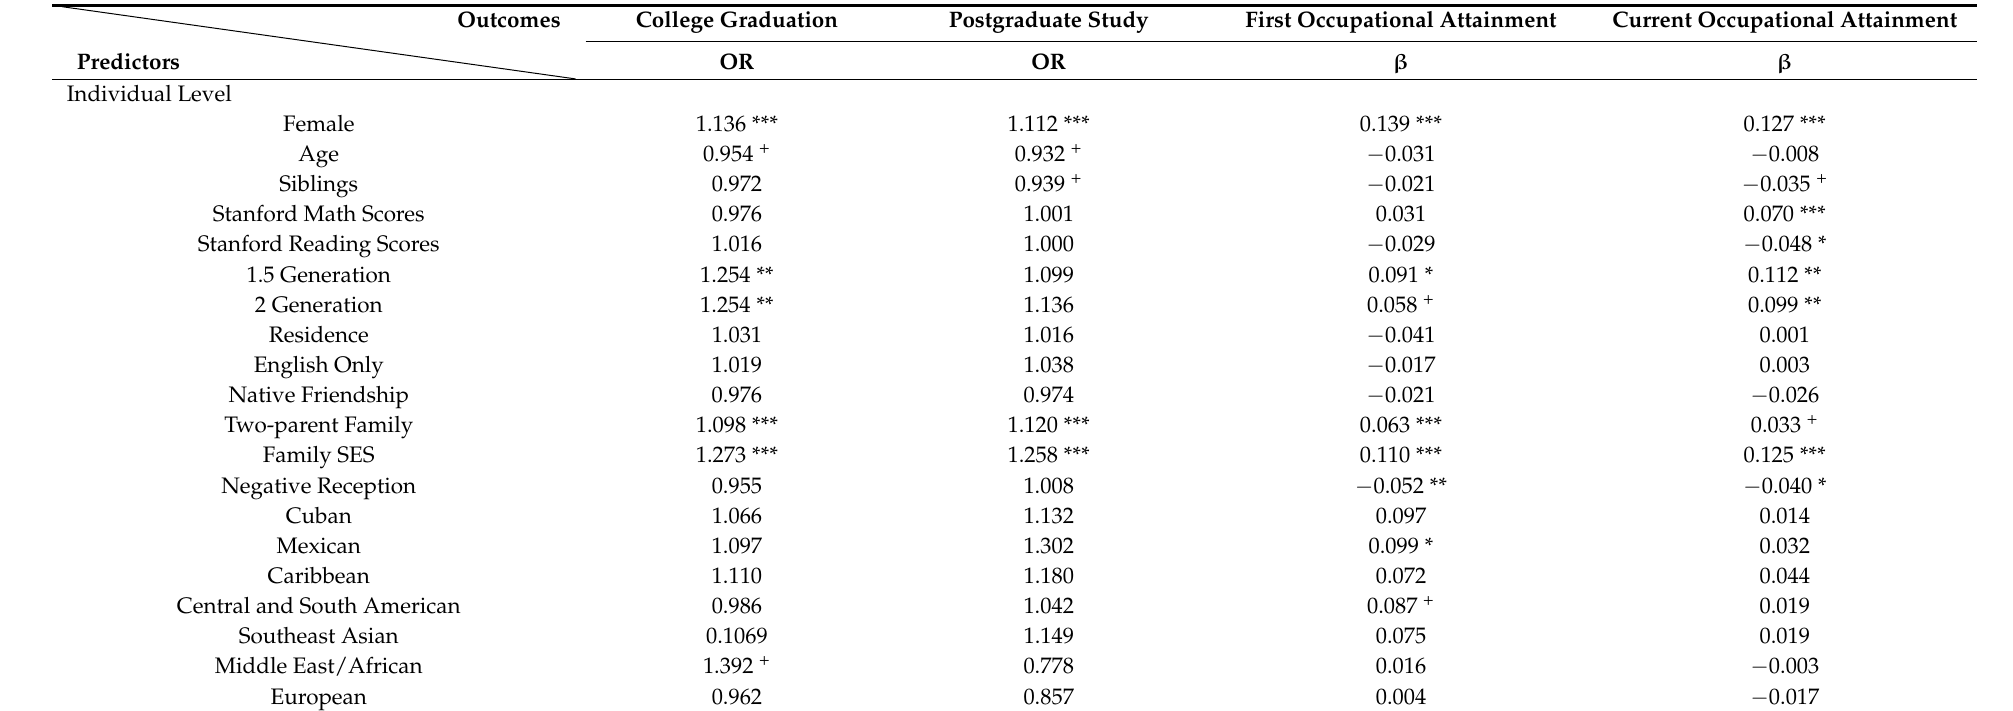
Table 4. Multilevel Modeling Effects of Social Forces on Adaptation Outcomes of Immigrant Children in Young